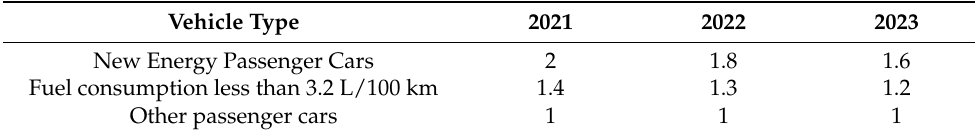
Table 1. Weight of output for vehicles.